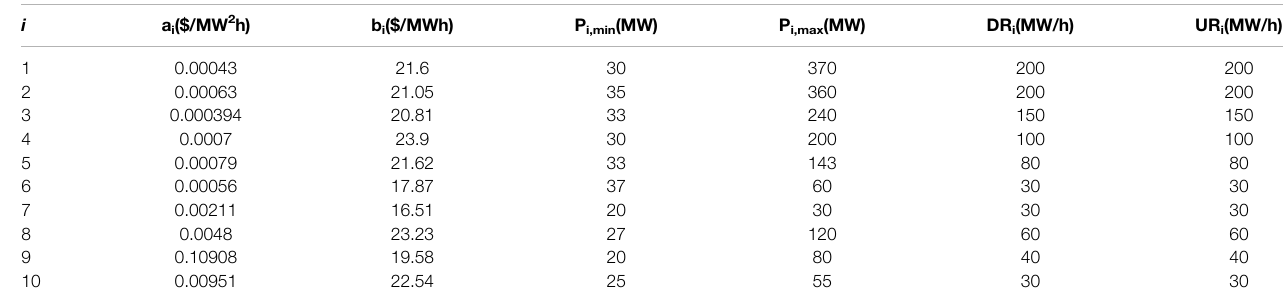
TABLE 6 | Ten conventional generators units data (Scenario-1, case study 2).